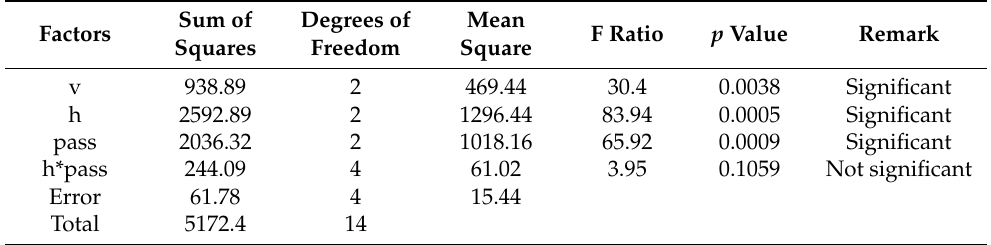
Table 8. ANOVA table for surface